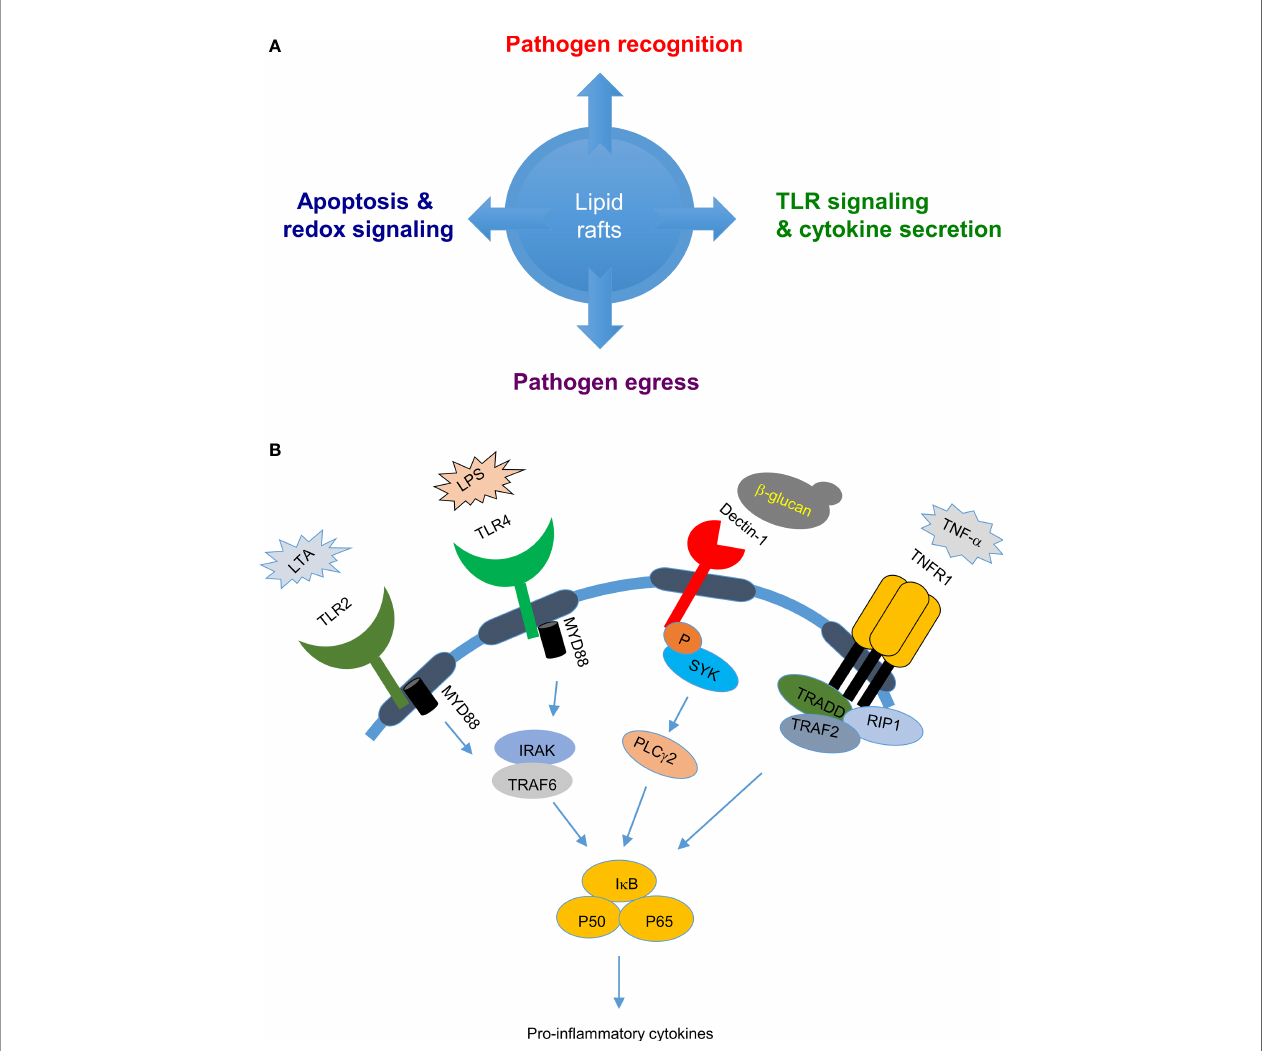
FIGURE 1 | Biological roles of lipid rafts in pathogen-host interactions: (A) Lipid rafts are involved in several cellular functions, such as pathogen recognition, cell signaling, and pathogen egress which decides the outcome of pathogen-host interaction. (B) Lipid rafts in pathogen sensing and cytokine release: Lipid rafts play an important role in pathogen sensing by recruiting pathogen sensing receptors such as toll like receptors when cells are stimulated with bacterial cell wall components LPS or LTA and C-type lectin receptors when stimulated with fungal cell wall components such as b -glucans which evetually leads to cytokine